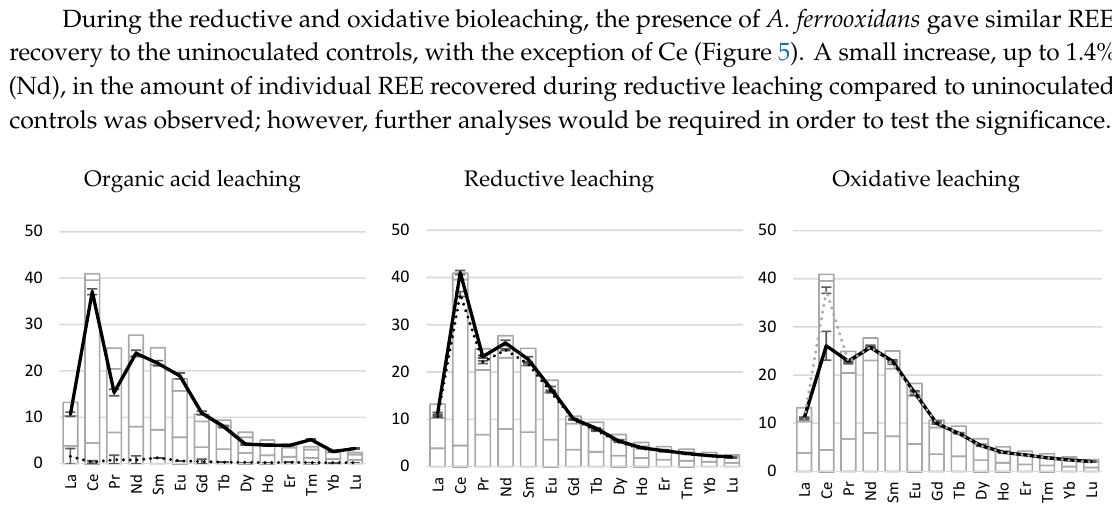
Figure 5. Recovery (%) of individual REE from low-Ca bauxite for each of the leaching techniques tested. Solid lines represent inoculated tests and dotted lines are uninoculated controls. Error bars are plus or minus one standard deviation of triplicate experiments. Bar charts show sequential extraction data, as in Figure 4.